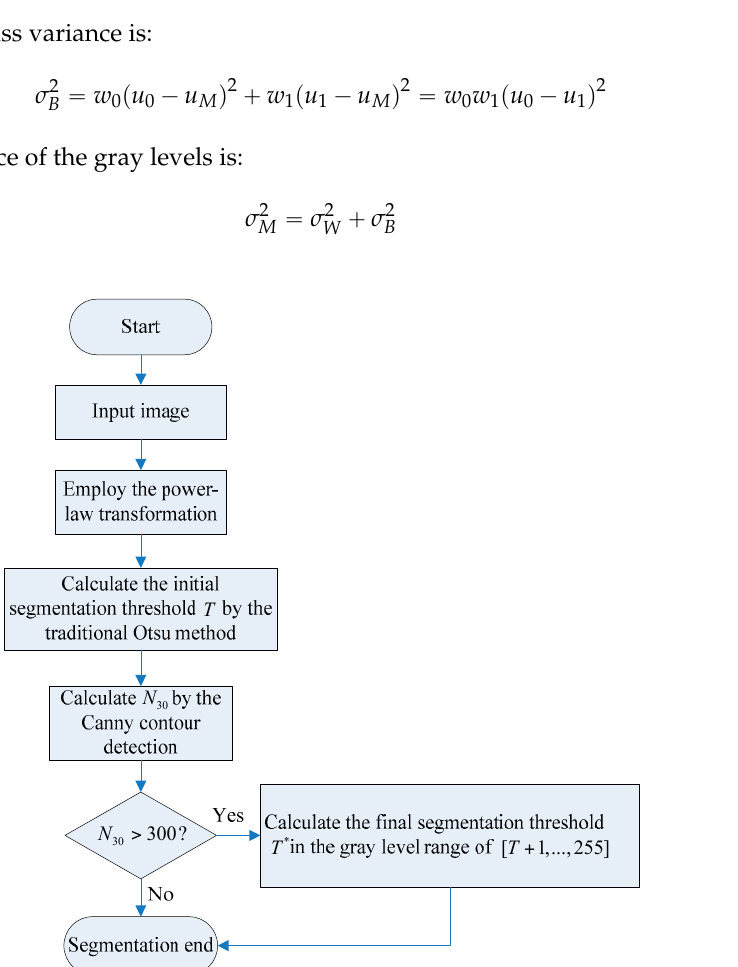
Figure 2. The procedure of the improved Otsu TSM.